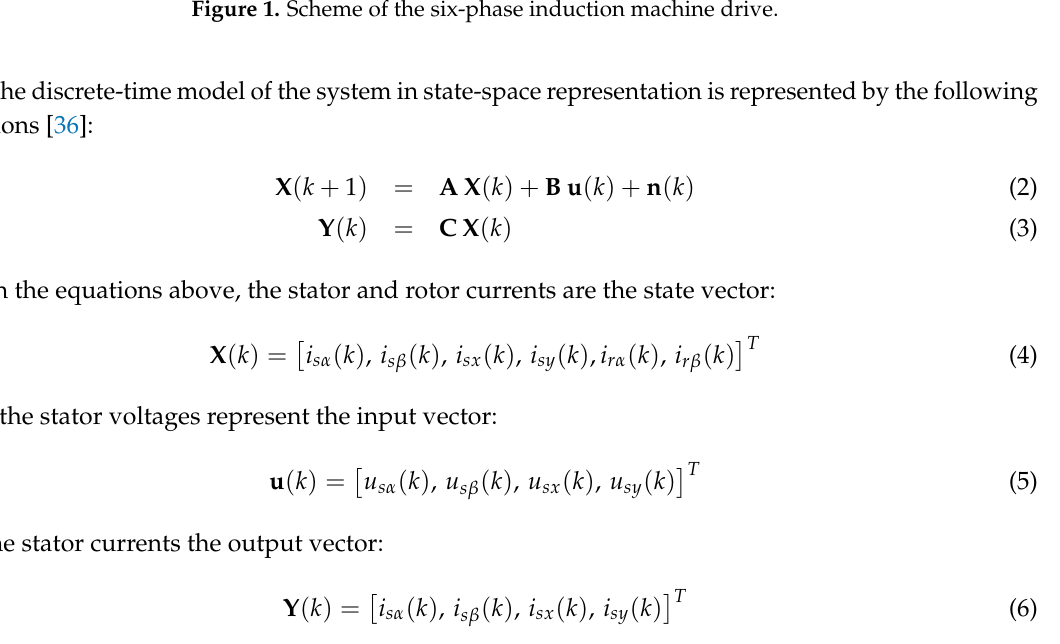
Figure 1. Scheme of the six-phase induction machine